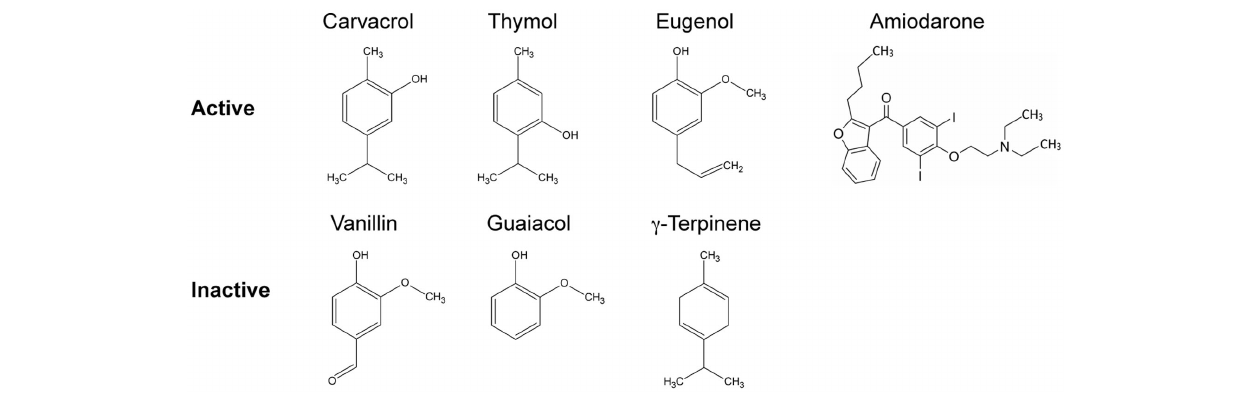
than 0.5mg/ml are grouped as inactive. Amiodarone, a cationic amphipathic drug used to treat cardiac arrhythmia that moonlights as an antifungal agent, also elicits ion